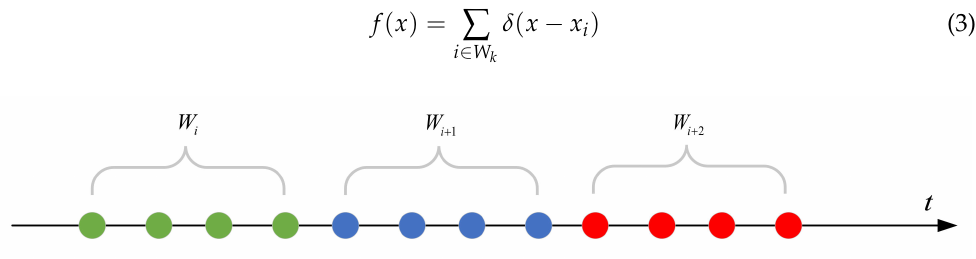
Figure 2. Windows of event stream.